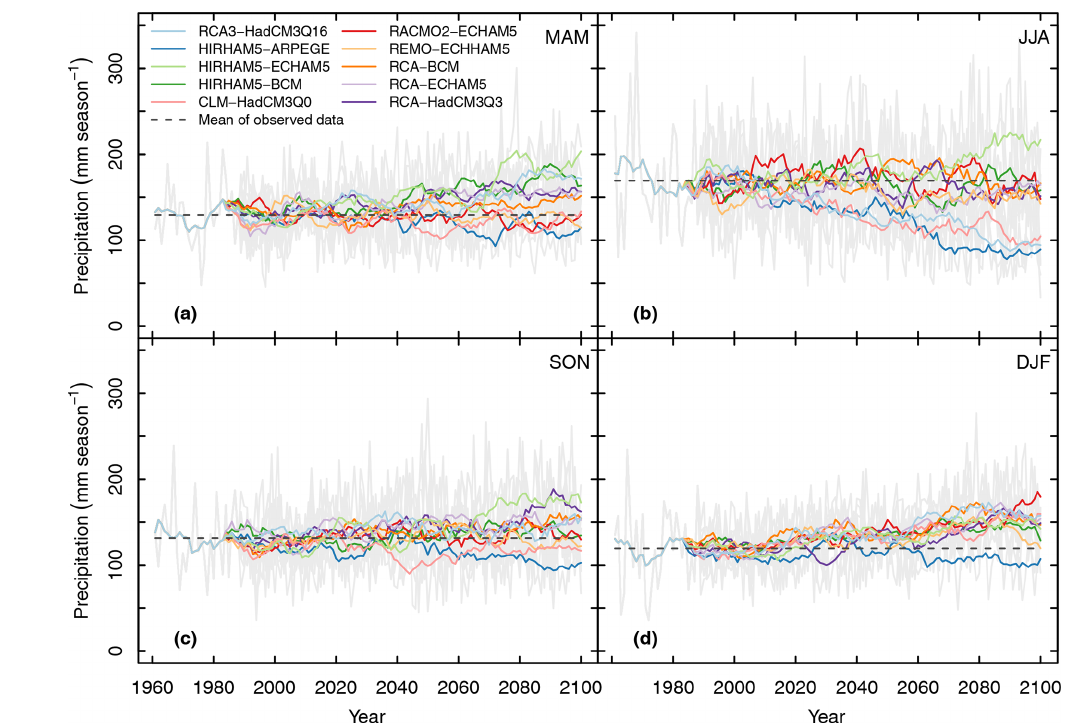
Figure 8. Seasonal precipitation simulated with 10 climate models for the station Geisenheim (Rheingau), Germany, for the emission scenario RCP8.5. Grey lines show the range of annual values of all models, coloured lines 11-year running means for individual model runs. The period from 1961–1988 represents observed data and the dashed baselines illustrate their mean values. (a) MAM, spring, March, April, May; (b) JJA, summer, June, July, August; (c) SON, autumn, September, October, November; (d) DJF, winter, December, January,